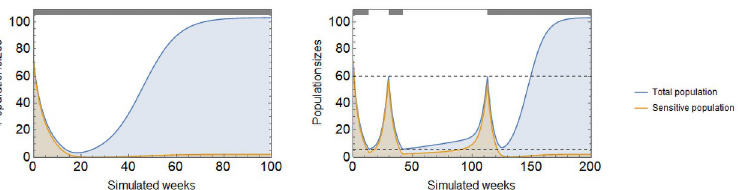
Fig 4. Continuous and adaptive therapies. Continuous cytotoxic therapy yields a good initial response, drives down tumor burden, but the population rebounds once cancer coordinates on the resistant type (left). Under adaptive therapy control over the tumor is lost when it enters the resistant basin of attraction, which happens when composition falls below g = 40%, in the present case is after 3 treatment cycles (right). Parameters: r 1 = 0.4, r 2 = 0.2, d 1 = d 2 = 0, K = 150, c 1 = c 2 = 0.05, m 1 = m 2 = 0.01, α = 2, γ 1 = 0.4, γ 2 = 0.